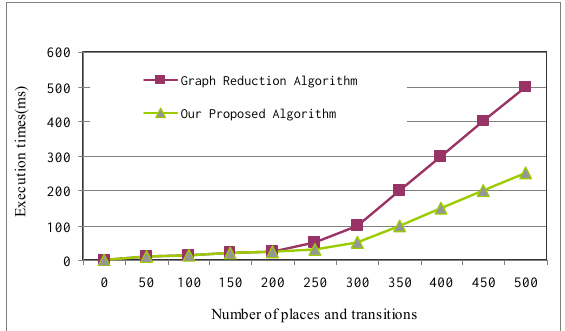
Fig.2 (cid:24) . Verification for conferencing notification